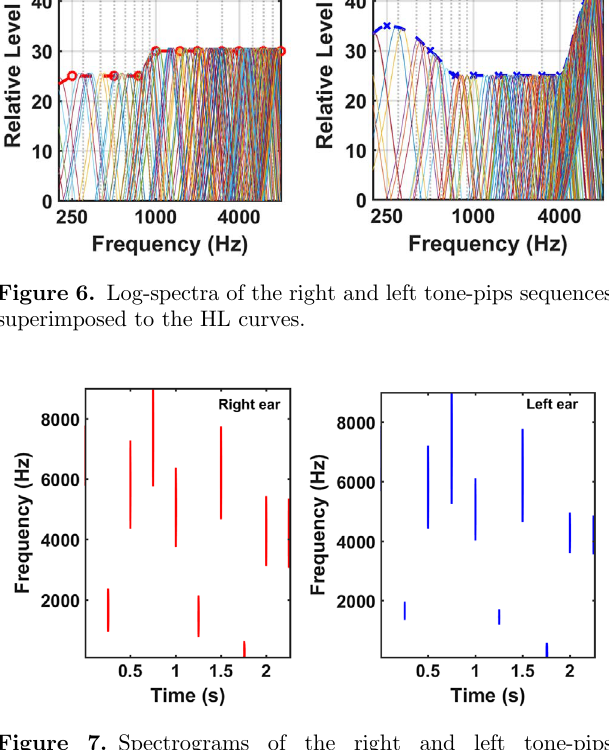
Figure 7. Spectrograms of the right and left tone-pips sequences (2 s, 4 pulses/s). A 2.9 ms Blackman window is used with a hop of 0.22 ms; the Fourier transform is carried out on 4096 points.